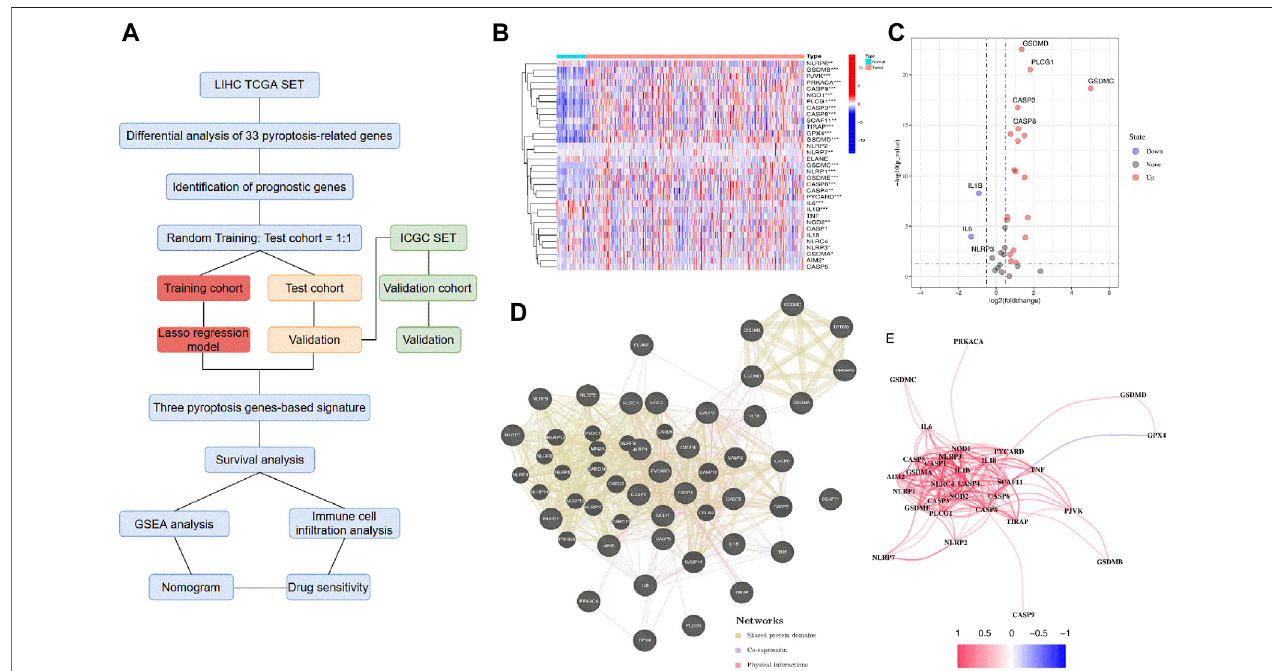
FIGURE 1 | Screening of the PRGs in the HCC patients from the TCGA database. (A) Flow chart of the study. (B) Heatmap of the differential gene expression between the normal and the tumor tissues. (C) Volcano plot of the differentially expressed PRGs. (D) PPI network of the interactions among PRGs. (E) The correlation network (Redline: positive correlation; Blueline: negative correlation. The depth of the colors re fl ects the strength of the relevance).